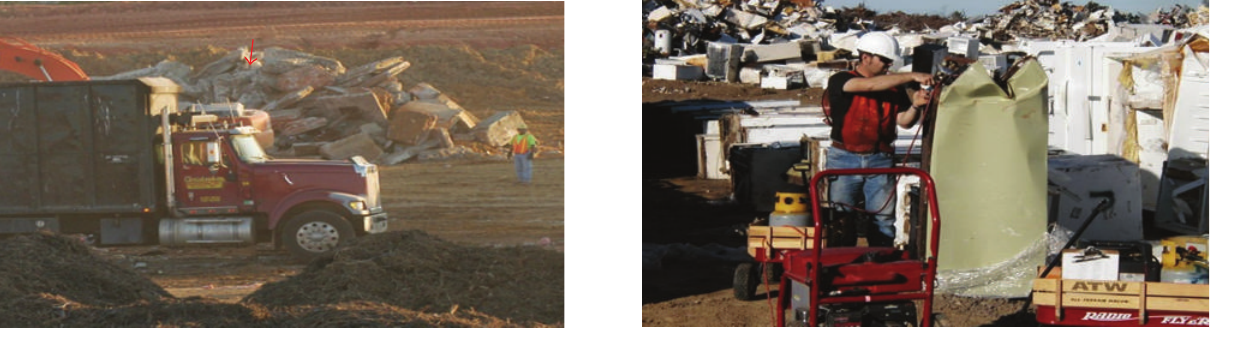
Figure 8: Refrigerant being reclaimed from white goods in Hancock County,